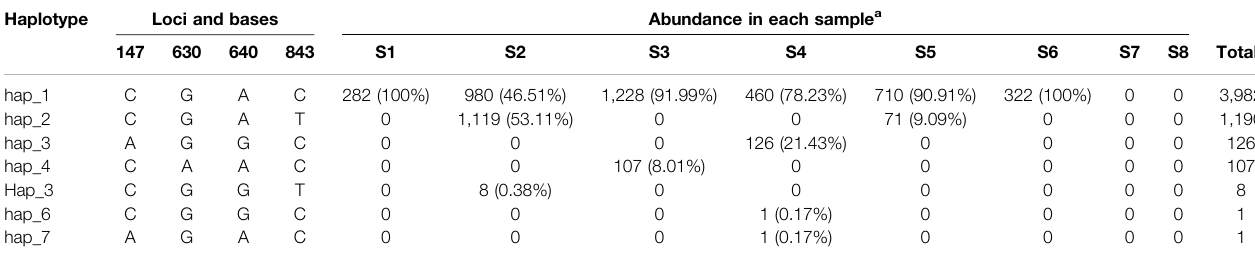
TABLE 4 | The forming and abundance of NA haplotypes in H1N1.